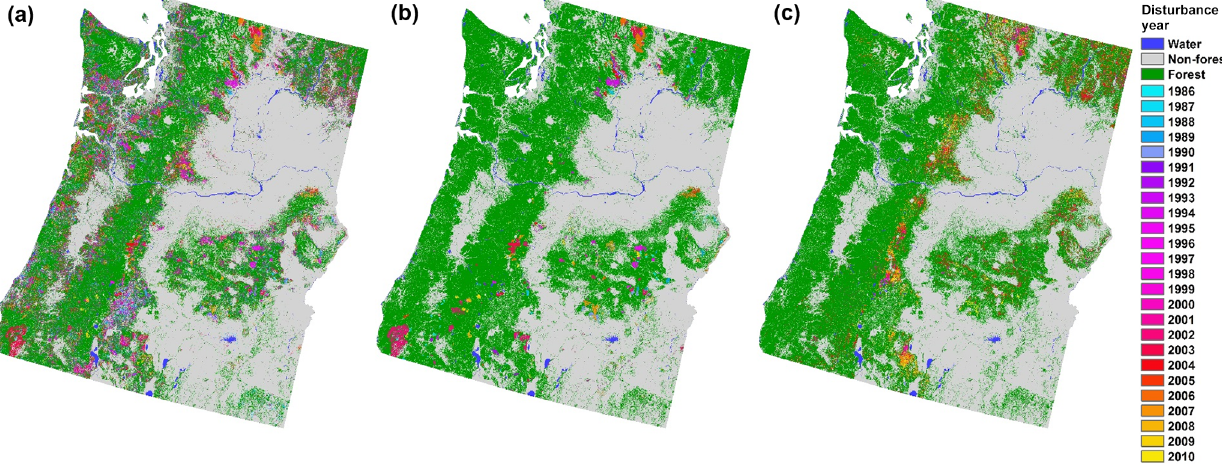
Figure 1. Year of last disturbance from (a) NAFD, (b) MTBS, and (c) ADS data of the PNW region. The time periods for NAFD, MTBS, and ADS datasets are 1986–2010, 1986–2010, and 1997–2010, respectively. NAFD: North American Forest Dynamics, MTBS: Monitoring Trends in Burn Severity, ADS: aerial detection